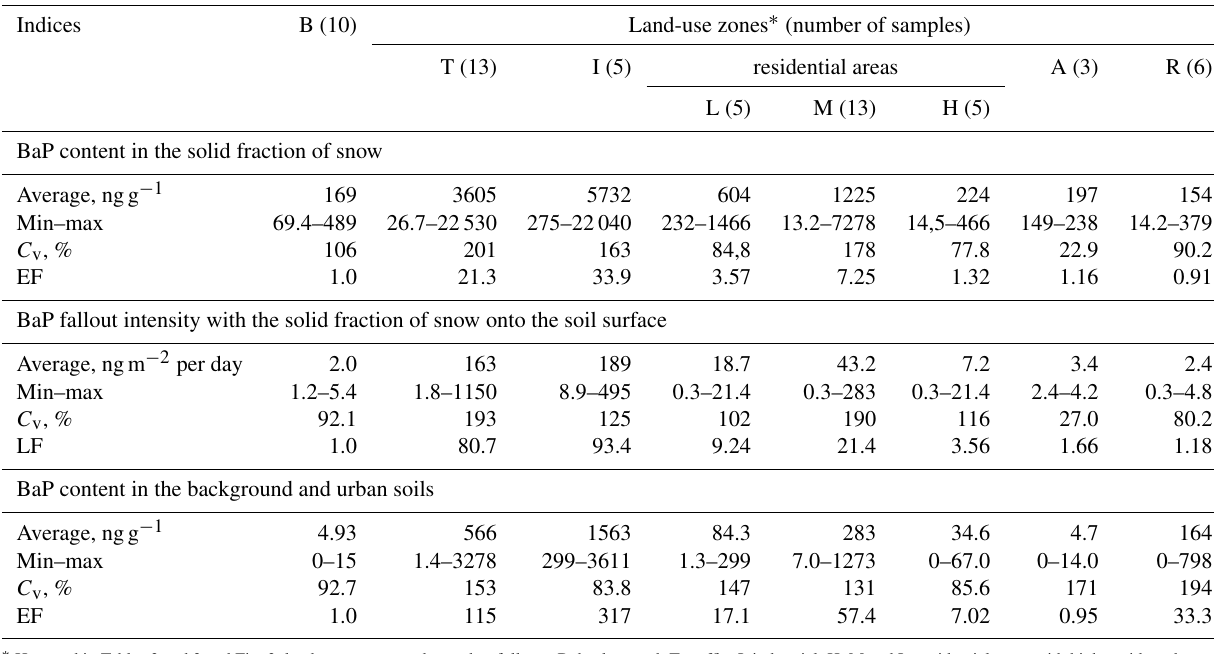
Table 1. BaP contents in the solid fraction of snow and BaP fallout intensities in the winter period for the background territory and the land-use zones in the EAD of Moscow